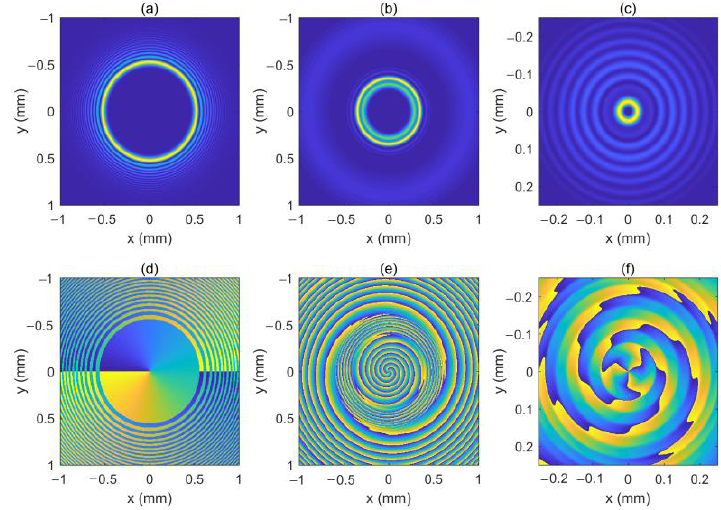
Figure 4. The intensity pattern and phase distribution of the right-hand circular polarized (RHCP) component at different distances. ( b , c ) show the intensity pattern for z = 100 mm and z = 180 mm, respectively; ( e , f ) show the phase distribution for z = 100 mm and z = 180 mm, respectively. The intensity pattern and phase distribution of the initial beam are also shown in ( a , d ).